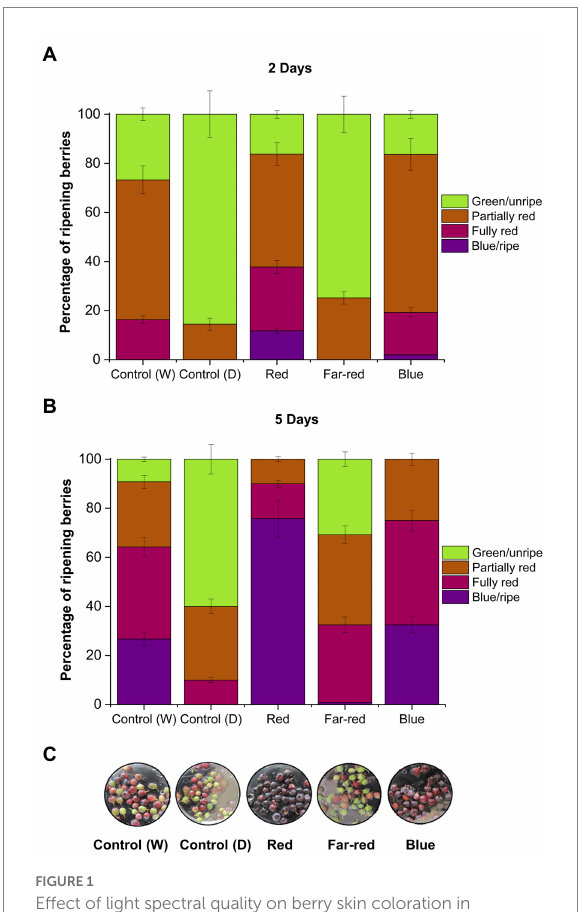
FIGURE 1 Effect of light spectral quality on berry skin coloration in detached berries after D2 (A) , D5 (B) , and D7 (C) from the beginning of light treatments. Berry coloration is expressed as mean ± SE of three replicates. “Control” represents berries under ambient white light (W) or under dark conditions